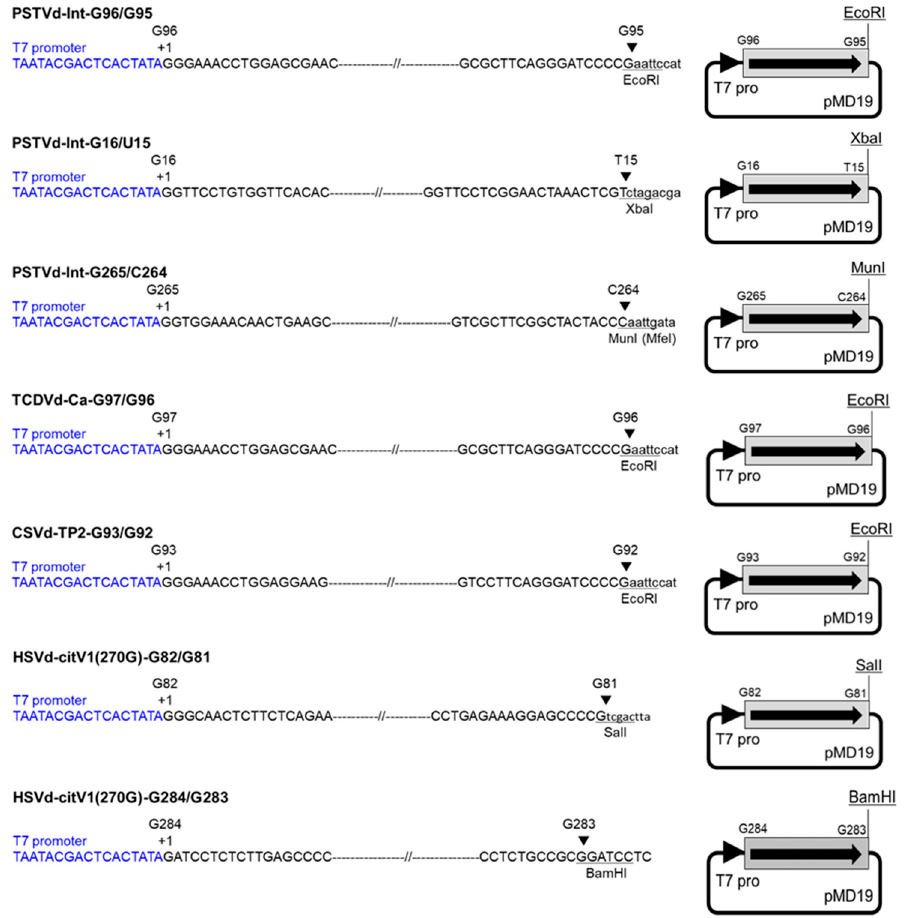
Figure 1. Construction of monomeric viroid cDNA clones to transcribe complete monomeric viroid RNAs without any non-viroid sequence. The cDNA clones were linearized by digestion with respective restriction enzymes, and monomeric RNAs were transcribed with T7 RNA polymerase. Each arrowhead indicates the T7 promoter sequence (T7 pro) shown in blue letters. Each arrow indicates the direction of viroid sequence shown with a gray rectangle. PSTVd: potato spindle tuber viroid; TCDVd: tomato chlorotic dwarf viroid; CSVd: chrysanthemum stunt viroid; HSVd: hop stunt viroid.